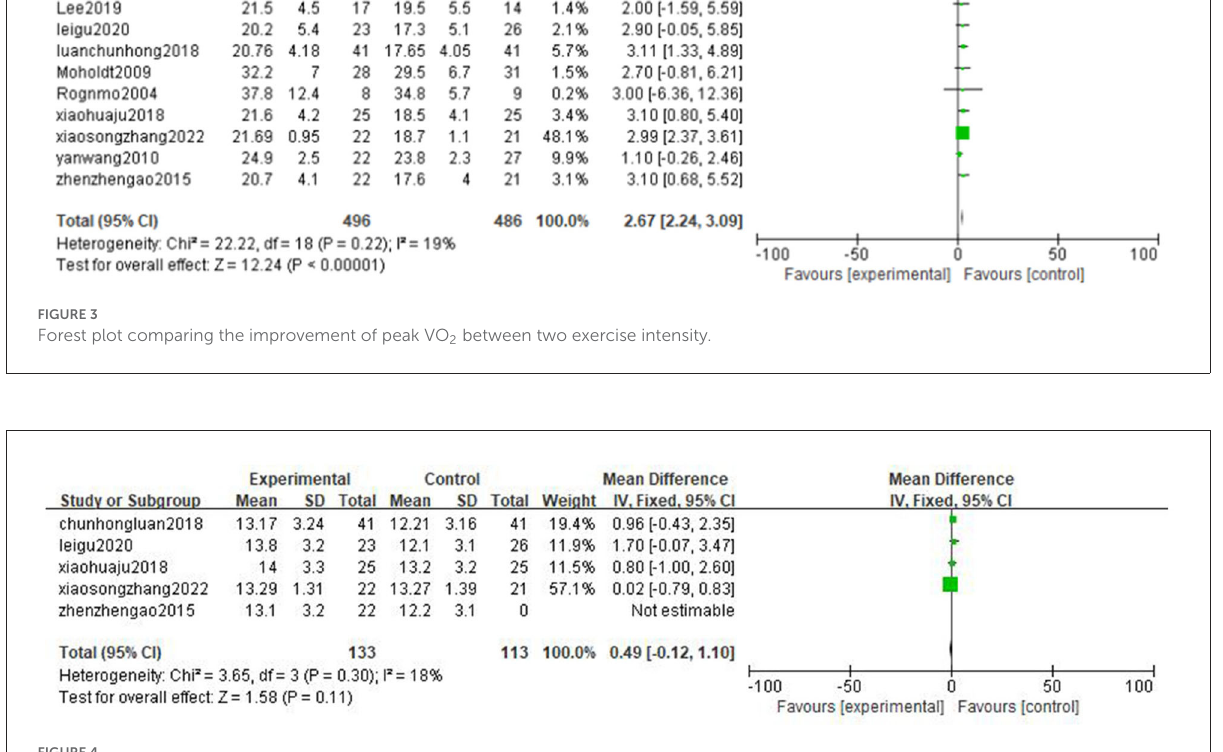
FIGURE4 Forest plot comparing the improvement of AT between two exercise modes.